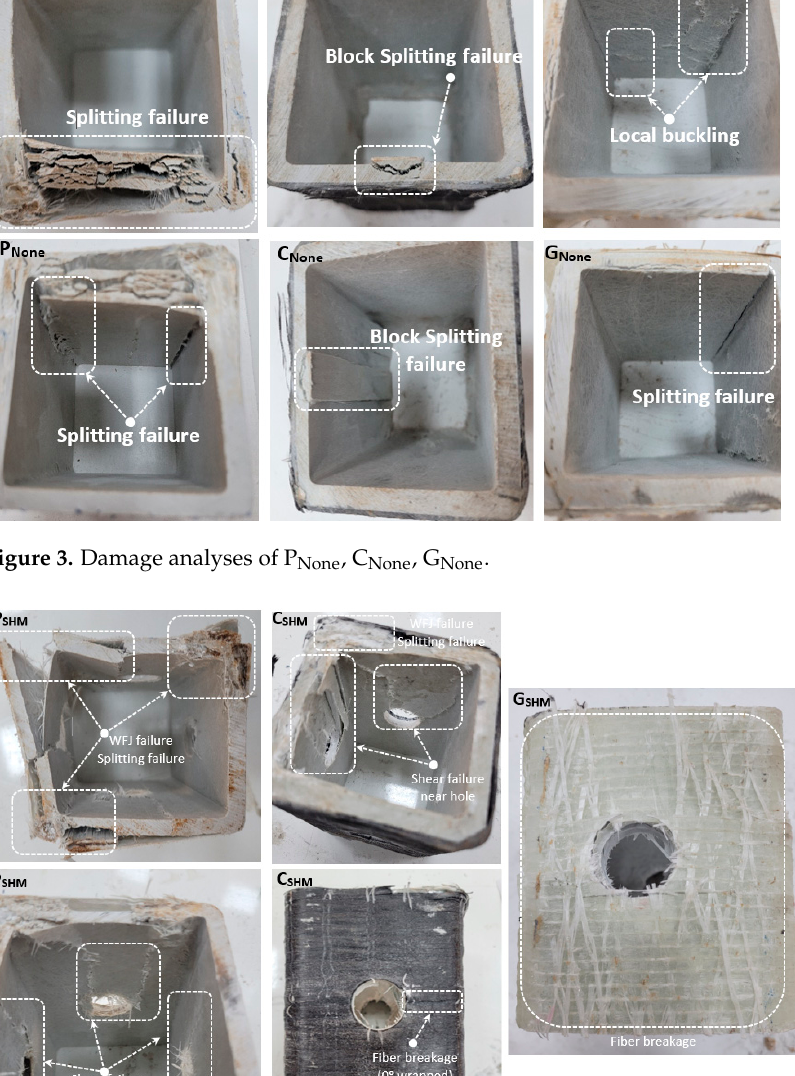
SHM , C SHM , G SHM